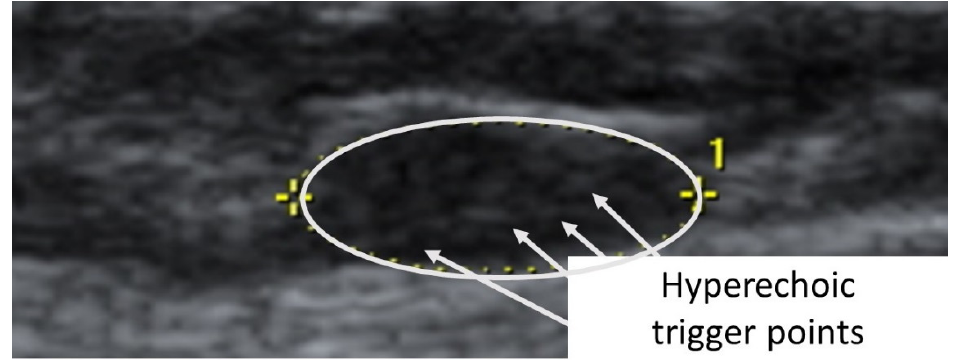
Figure 6. Detailed ultrasound imaging assessment of the left upper trapezius muscle showing a collection of small hyperechoic (hypoperfused) “TrP speckles” within the contracture knot .